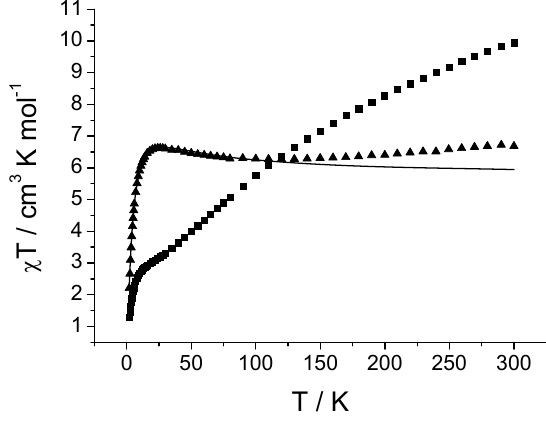
Figure 4. Magnetic data for 3 (triangles) and 5 (squares) and calculated curve for 3 (solid line) using the values in the text.